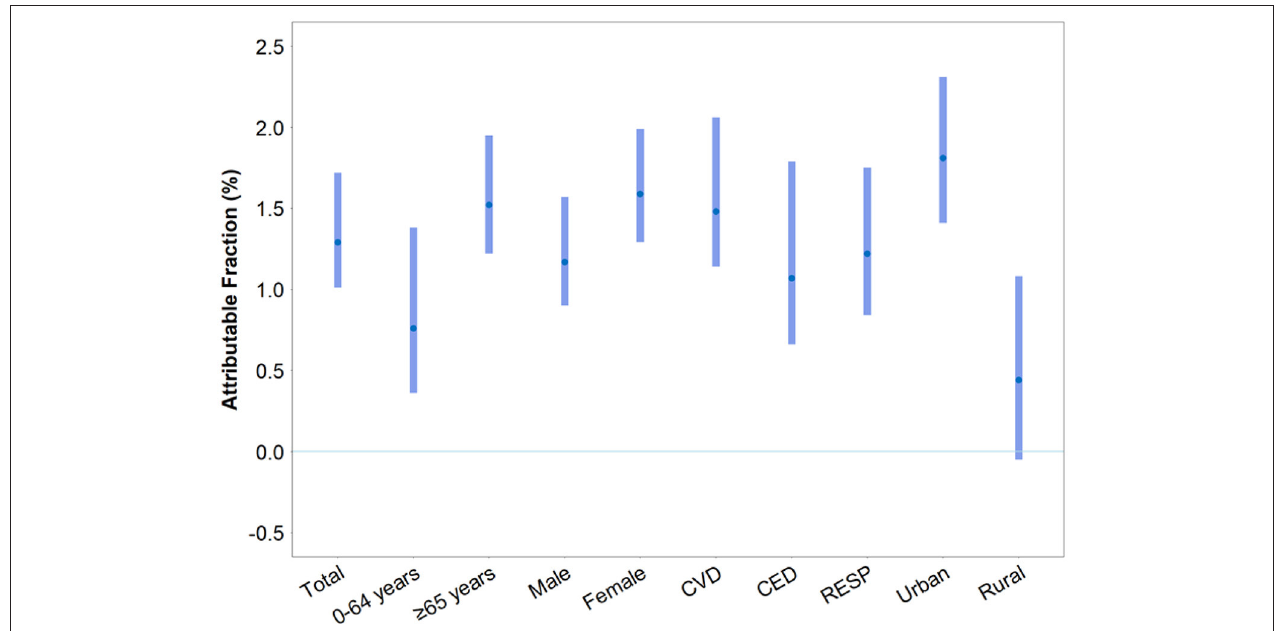
FIGURE 3 | Attributable fraction (AF) of mortality caused by the Spring Festival period in China.